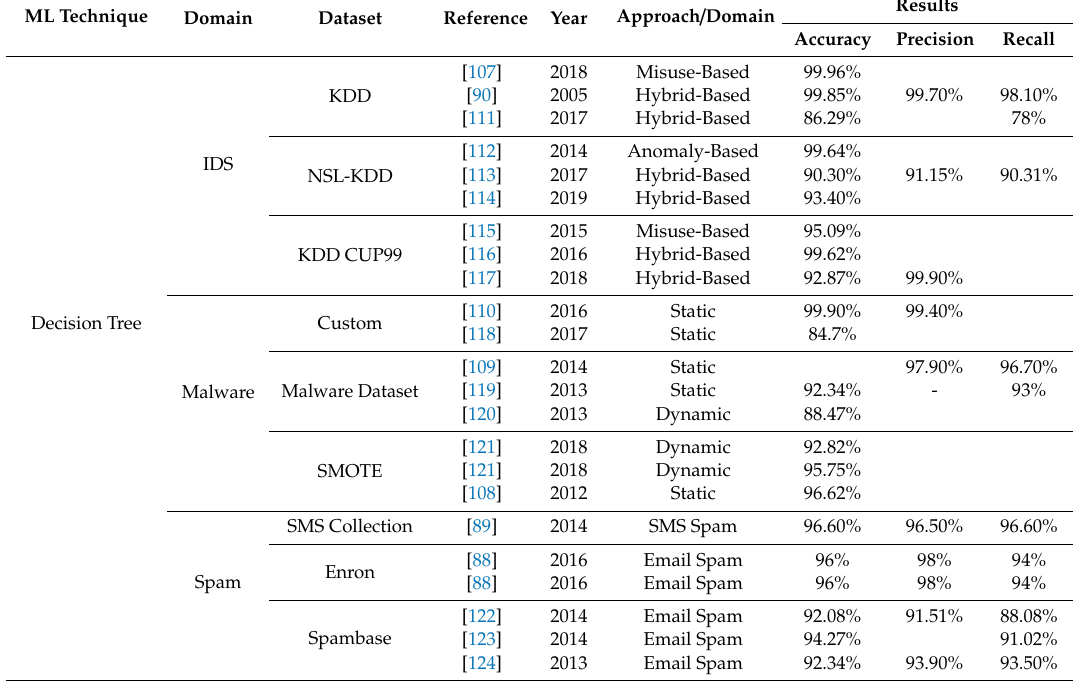
Table 5. Evaluation of Decision Tree in